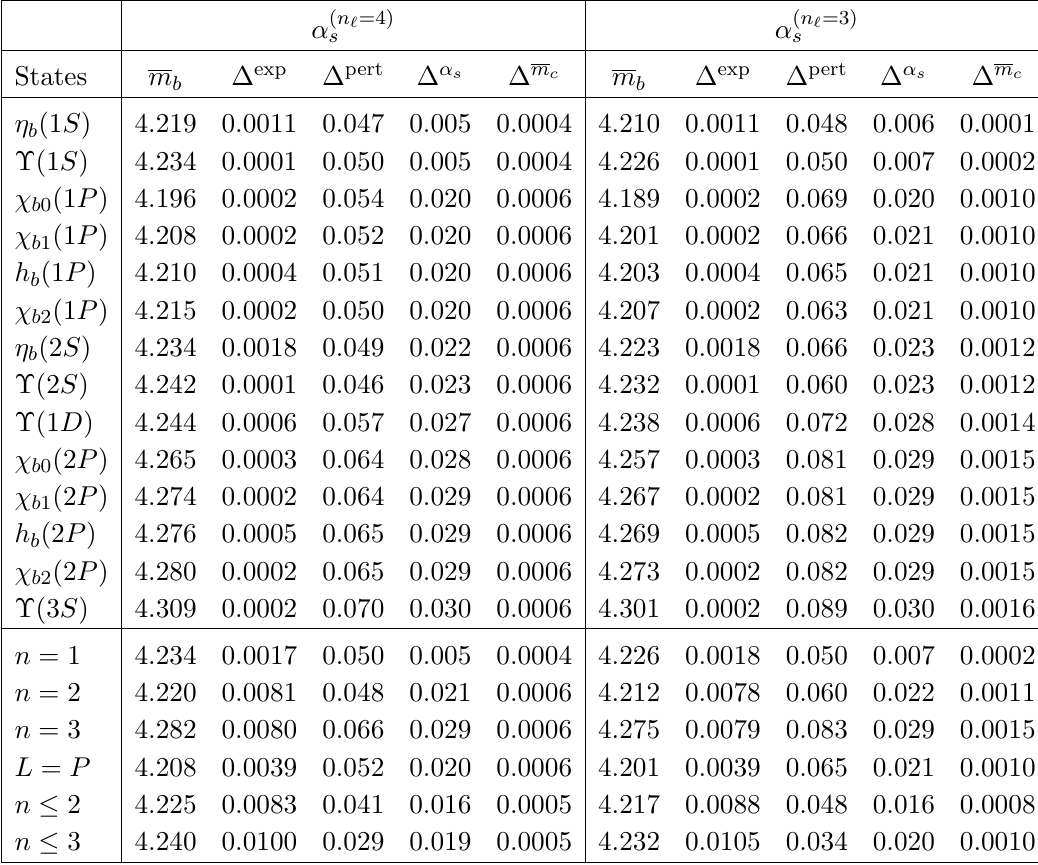
Table 2. Same as table 1 for the MSRp